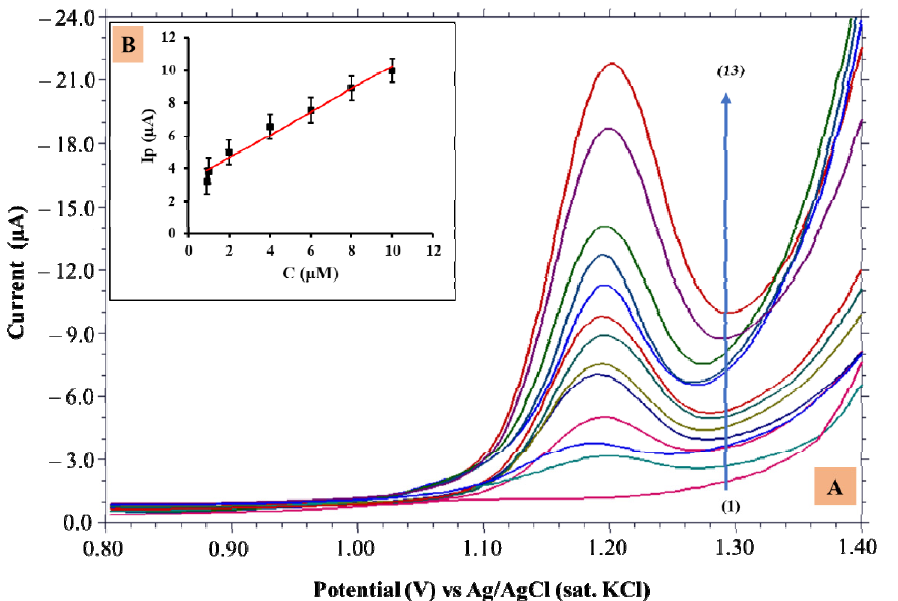
Figure 4. ( A ) Differential pulse voltammograms obtained for various TMP concentrations from 0.9 µ M–100 µ M (1–13); ( B ) Dependence of Ip vs. concentration. A linear range confined to a lower concentration was selected for quantification.